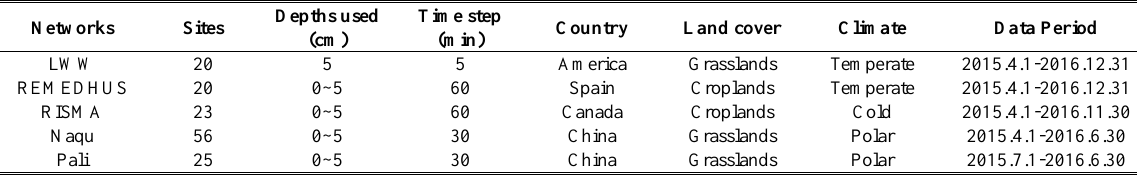
Table 1. Main information of the five networks used in the study